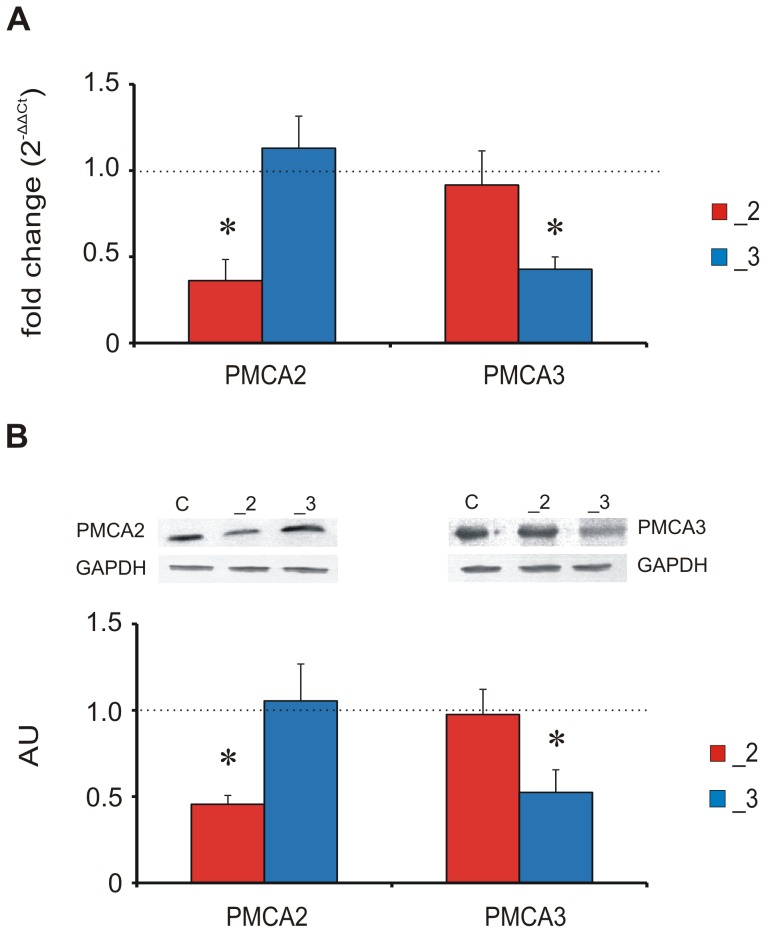
The efficiency of PMCA knockdown in a model of stable transfection.(A) The expression of genes corresponding to PMCA2 or PMCA3 was assessed using real-time PCR. The results are presented as relative units obtained after normalization to Gapdh expression. The level of expression of each target gene in control line was taken as 1 (dotted line). * P<0.05, PMCA-deficient lines vs. control cells. (B) PMCAs protein level assessed by densitometric analysis of immunoblots. The results are presented as arbitrary units (AU) obtained after normalization to endogenous GAPDH level. The dotted line presents the values for control line. * P<0.05, PMCA-deficient lines vs. control cells.